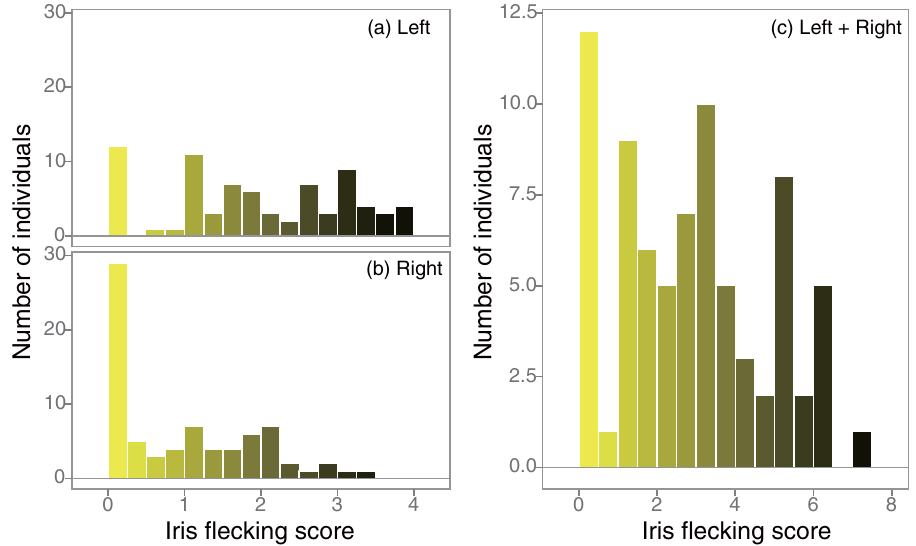
Figure 1. Frequency distribution of individuals according to the amount of iris flecking: ( a ) left eye, ( b ) right eye, and ( c ) both eye. The color was graded from bright yellow to black according to iris flecking